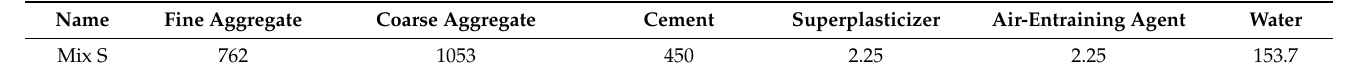
Table 1. Mix design details of the parent material (kg/m 3 ) (Data from [42]).